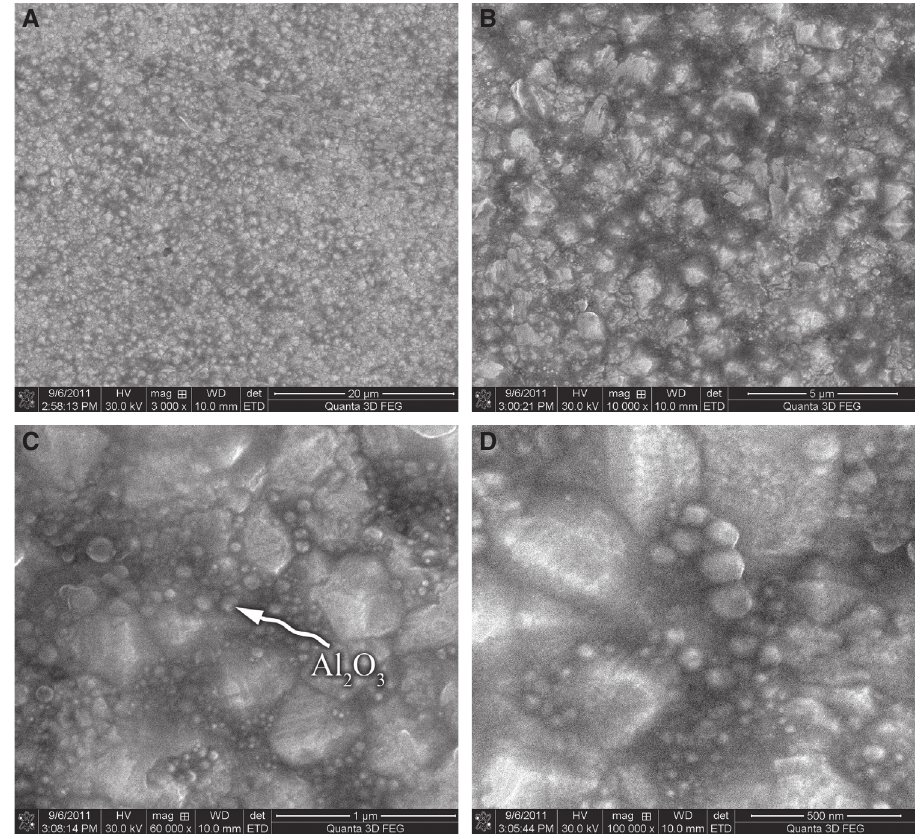
O composite coatings of optimized stainless steel specimen of AISI 2 3